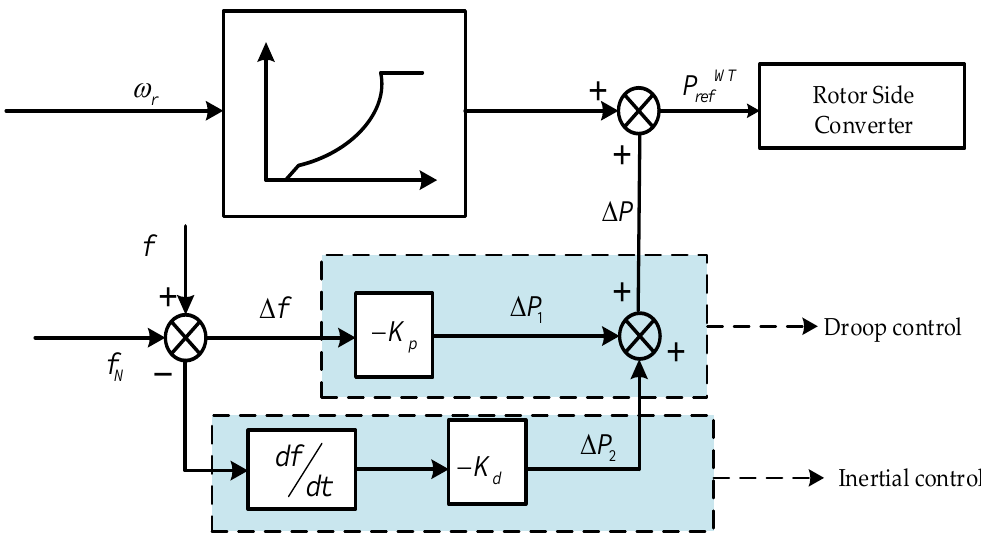
Figure 1. Conventional additional frequency control.